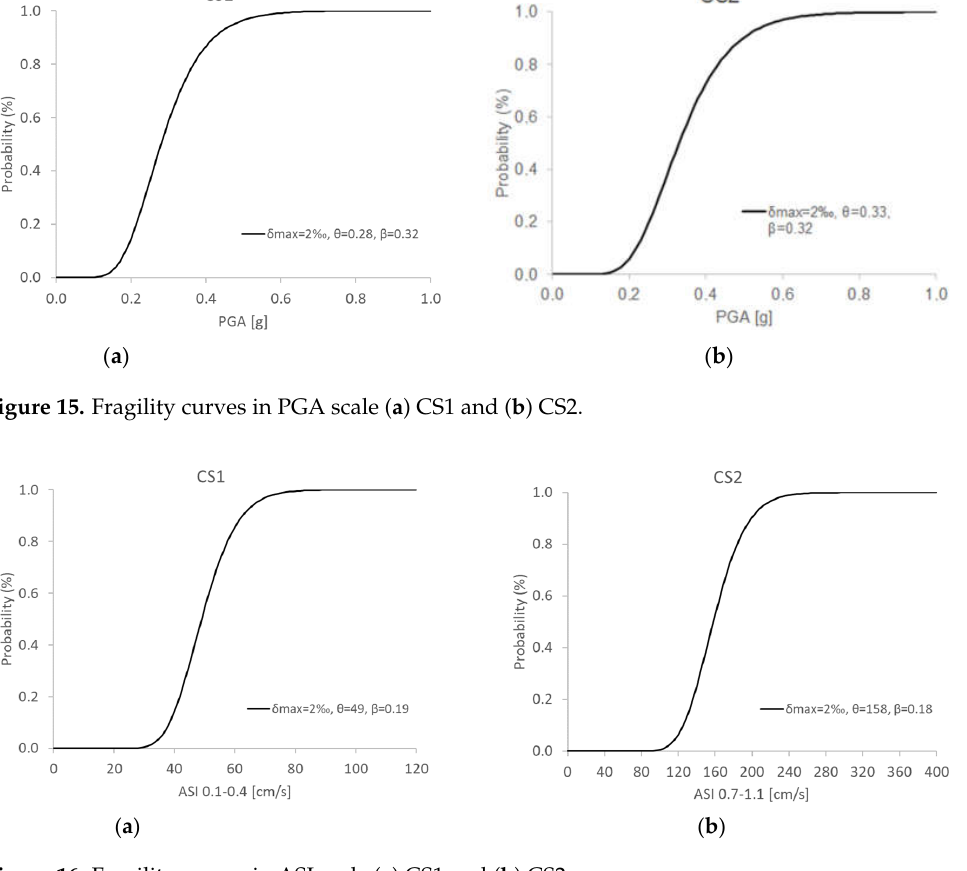
Figure 16. Fragility curves in ASI scale ( a ) CS1 and ( b ) CS2.